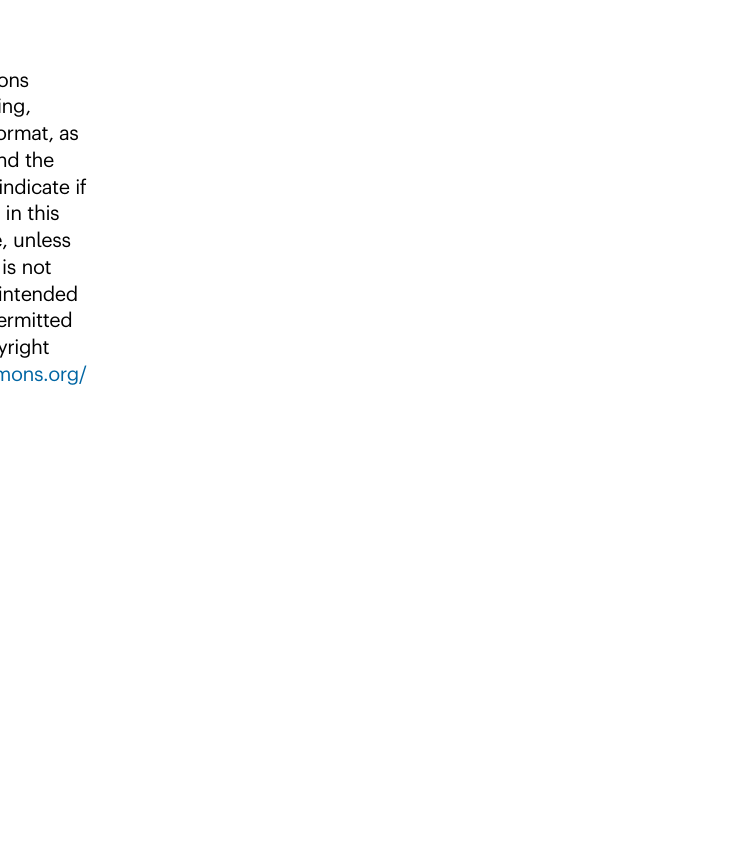
edge thickness of a few orders of magnitude thinner than their faces, or/and they can be covered by thick low polar dielectric fi lm. As such they will not contribute noticeable